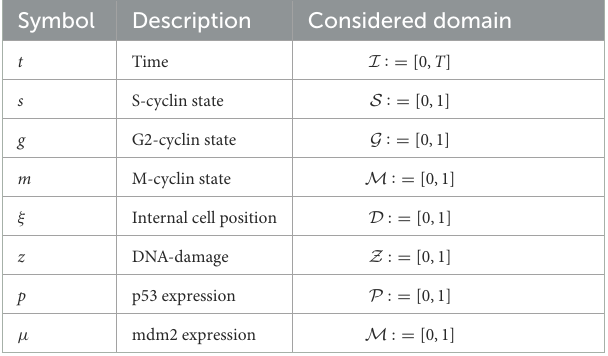
TABLE 1 Table of variables and the domains considered for simulating solutions to Equations (3), (27).